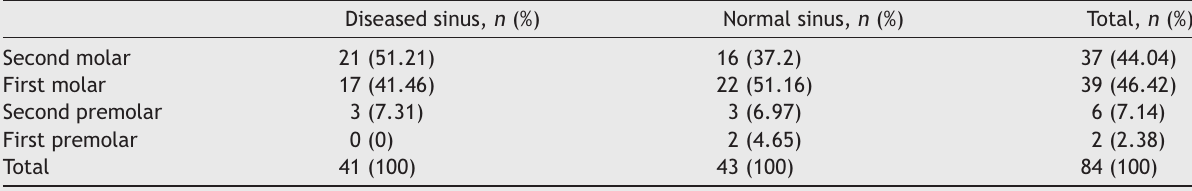
Number of roots inside diseased and normal maxillary sinuses, by tooth